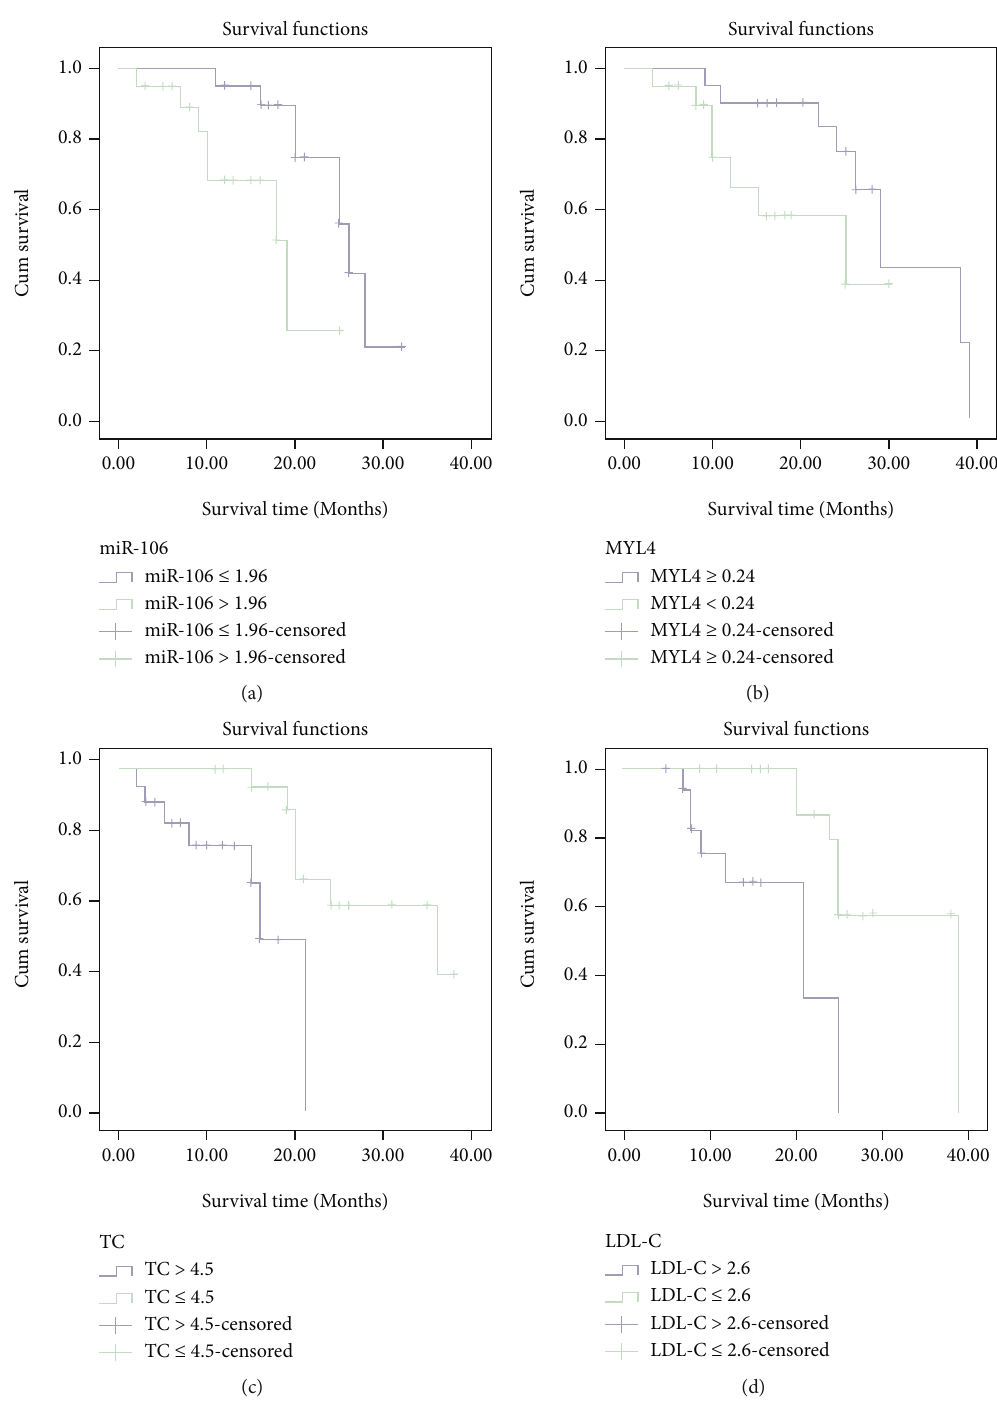
Figure 4: The relationship between serum miR-106 and MYL4 levels and the prognosis of AF. (a) Survival curve of patients with di ff erent miR-106 levels; (b) survival curve of patients with di ff erent MYL4 levels; (c) survival curve of patients with di ff erent TC levels; (d) survival curve of patients with di ff erent LDL-C